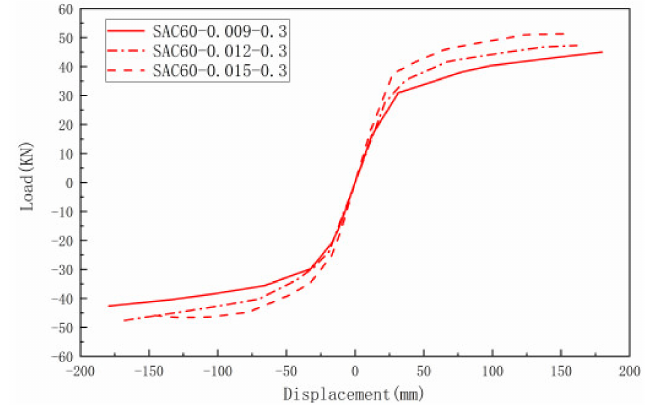
Figure 15. Skeleton curves of specimens.